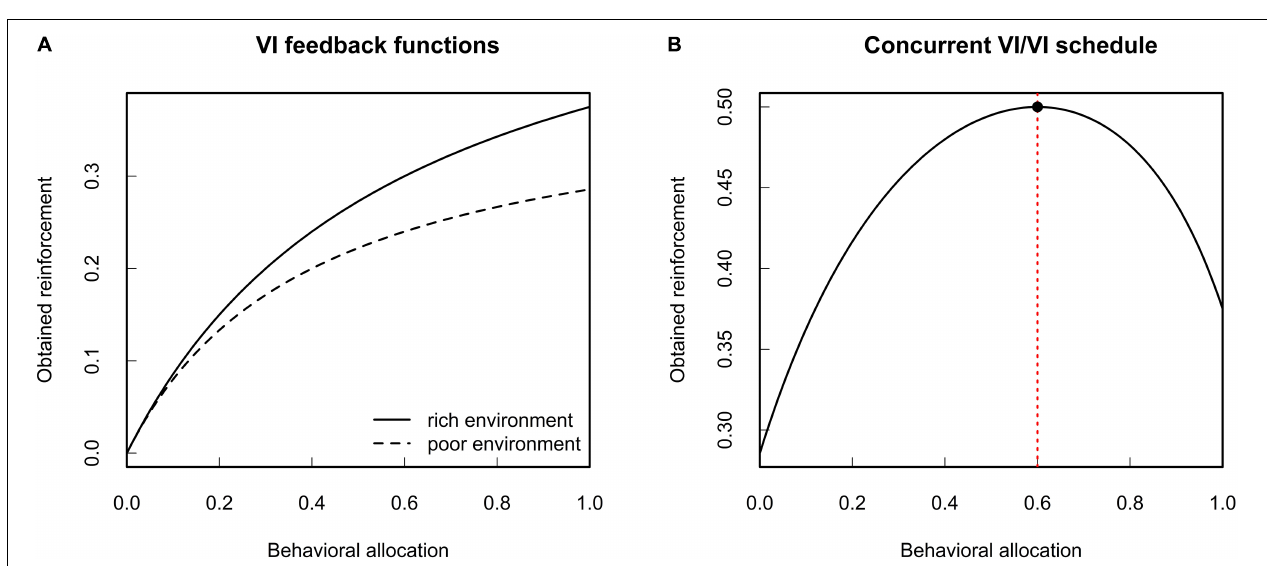
FIGURE 1 | Path model relating behavior b to evolutionary fitness w via reinforcement p. Following the MLBS, any statistical fitness predictor p will act as a reinforcer. The partial regression coefficients β pb and β wp designate the slope of the environmental feedback function relating behavior to reinforcement, and the slope of the fitness function relating reinforcement to fitness, respectively. The product of both partial effects constitutes the total effect of behavior on evolutionary fitness, which is equivalent to the reinforcer value r ( b ) of the behavior (see Borgstede, 2020 for details).